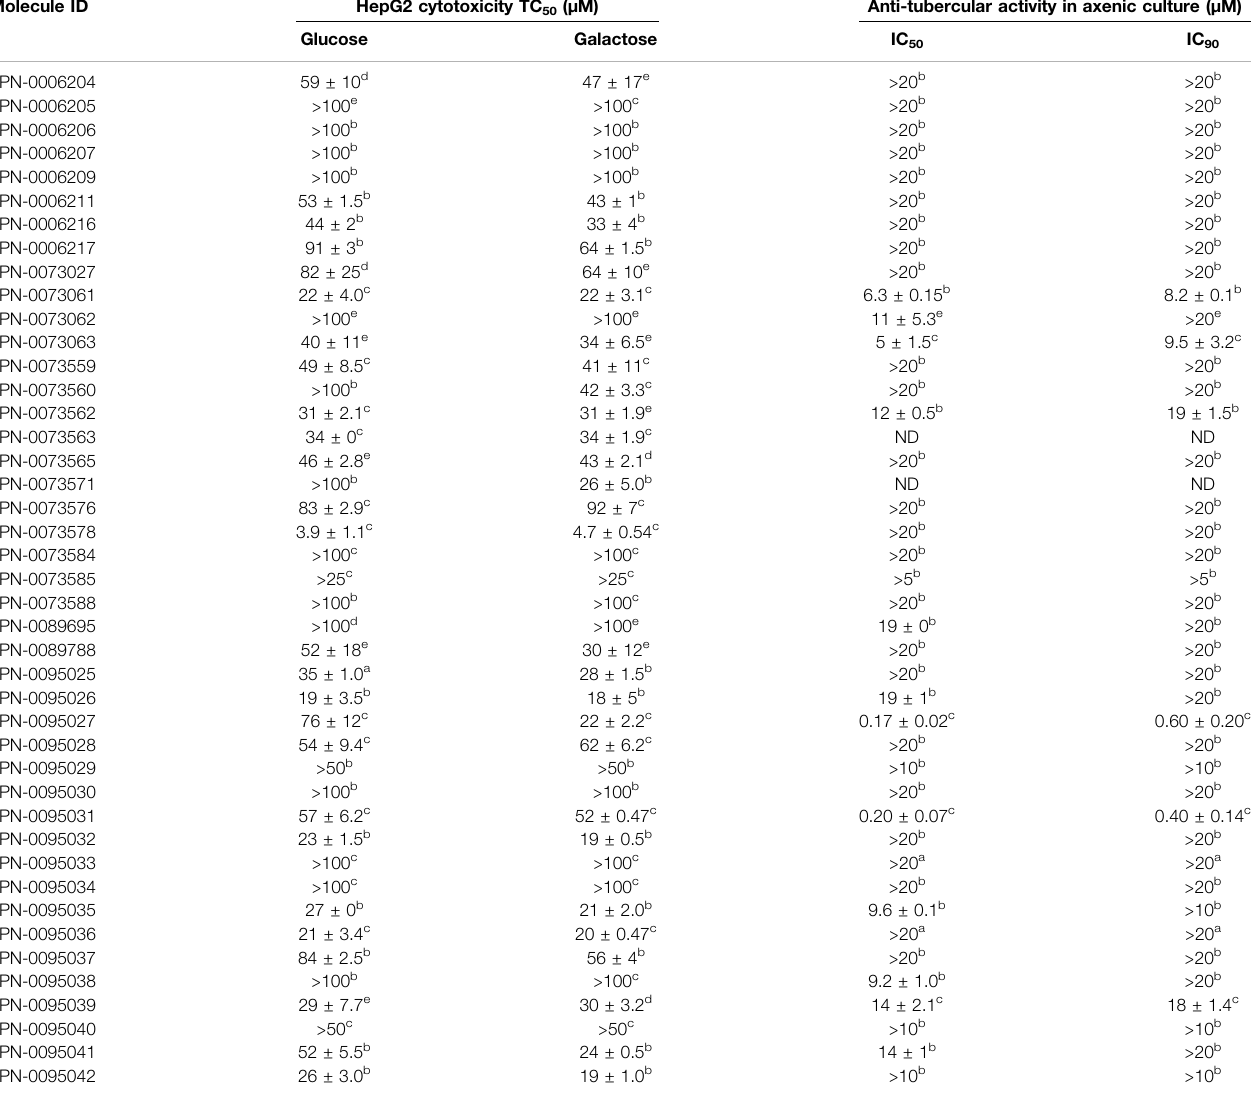
TABLE 2 | Cytotoxicity and activity against extracellular M.